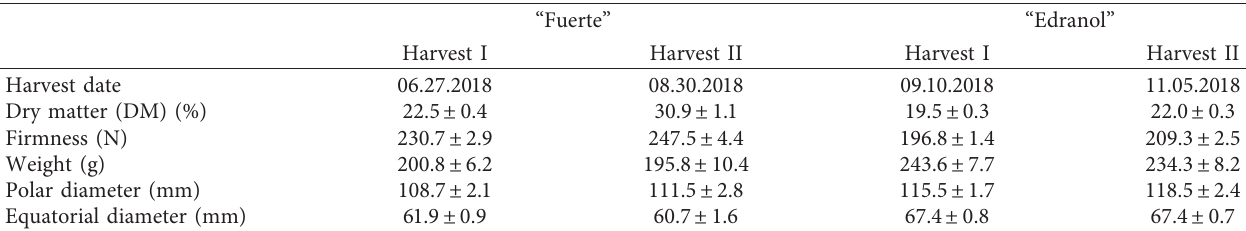
Figure 1: Dry matter content (%) during development of avocado fruit in “Fuerte” and “Edranol” varieties. Asterisk ( ∗ ) corresponds to harvest times. Each point corresponds to the mean ± standard Table 1: Quality variables at both harvest times in “Fuerte” and “Edranol” avocado fruit.